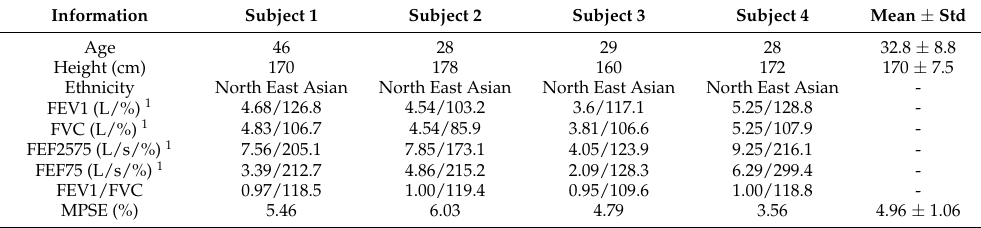
Figure 6. PSE maps of eight slices on two subjects. Both datasets show the obvious increase on PSE distribution from anterior to posterior region. Over four subjects, the whole lung MPSE varied between 3.56% and 6.03% (4.96 ± 1.06%), consistent with Bloch simulation and results displayed in Figure 5c. Table 1 is the summary of the demographic information and pulmonary function test of subjects. Table 1. Subject demographic information, as well as median PSE of masked OE